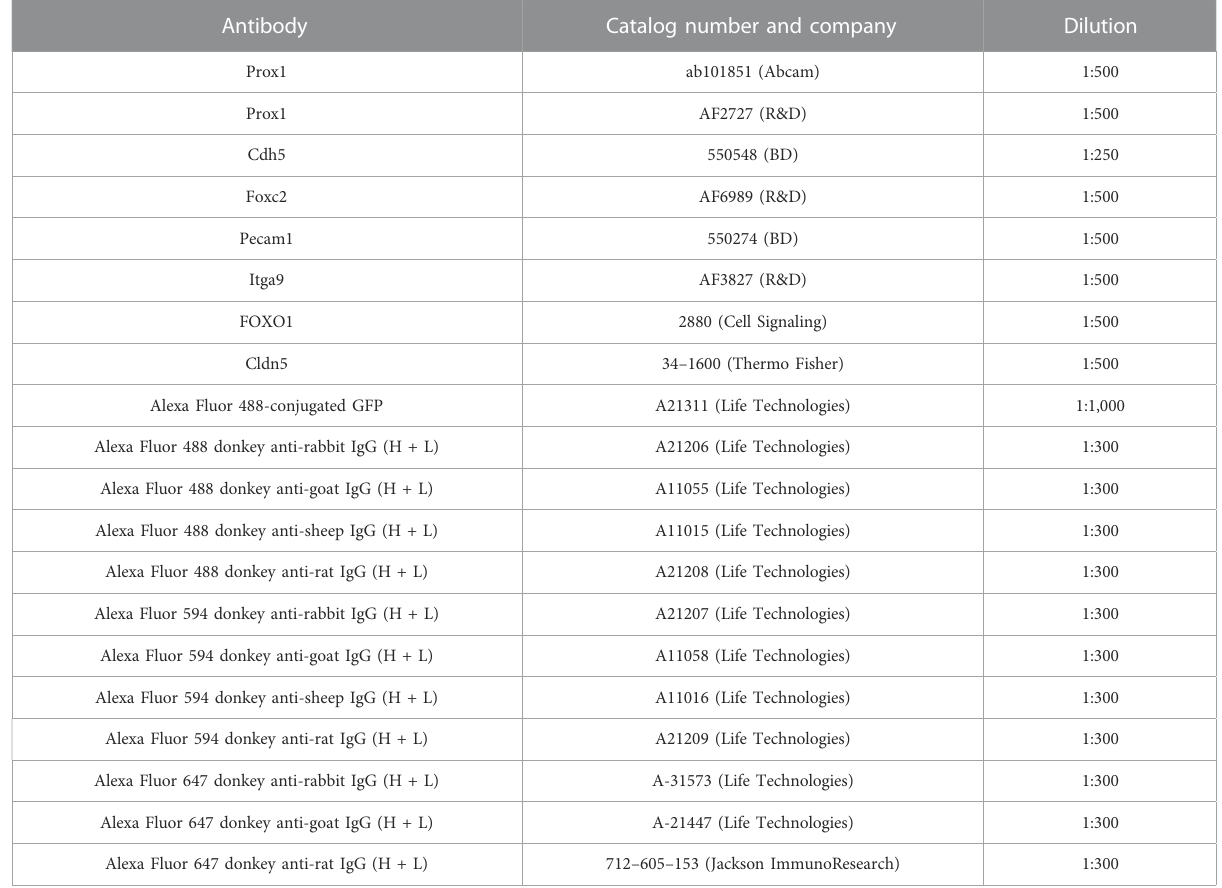
TABLE 1 Immunostaining antibodies. Antibody Catalog number and company